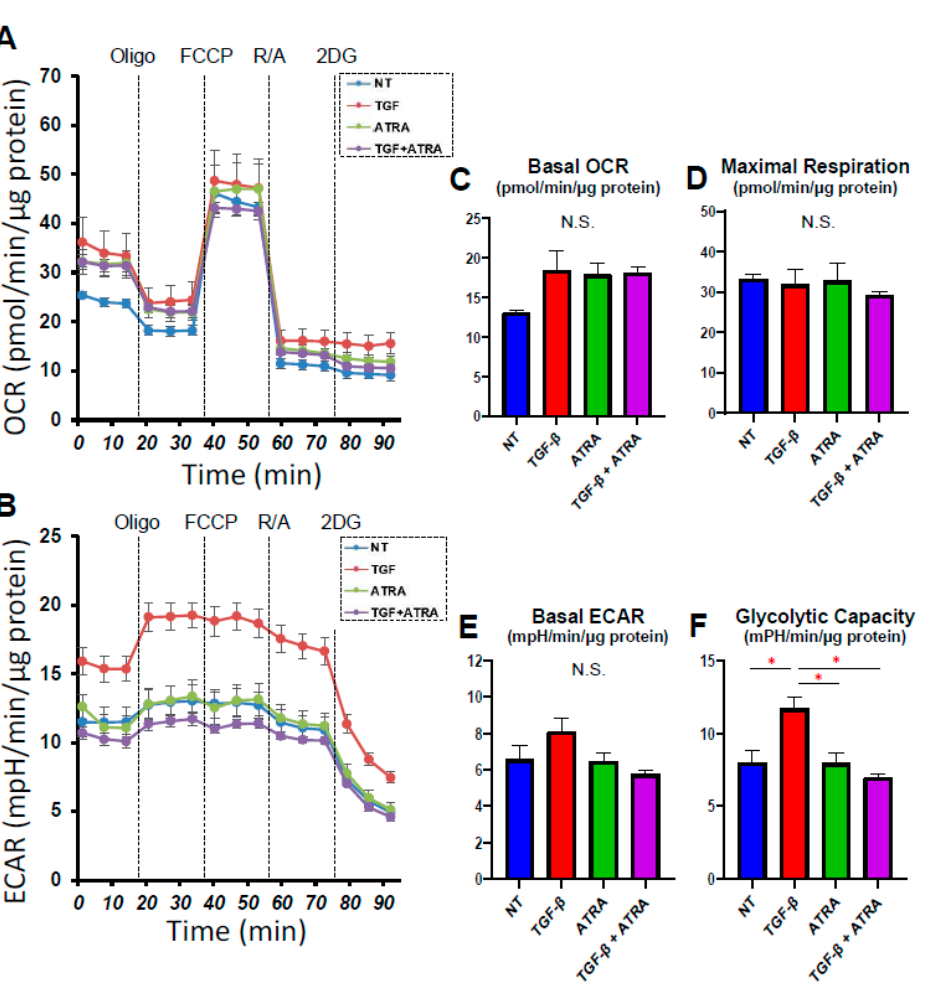
of the 3D spheroids rather than the total expressions detected by qPCR analysis. Similar to these effects observed in ECM molecules, the gene expression of their modulators, TIMPs, MMPs, and ER-stress-related factors, were not significantly affected by TGF- β 2, except Figure 1. Effects of barrier functions of TGF- β 2 untreated or treated HconF 2D monolayers. HconF for the upregulation of MMP2 (2D). In the case of 2D and 3D cultures, ATRA significantly cell 2D monolayers treated with TGF- β 2 (TGF β , 5 ng/mL) and untreated monolayers were subjected modulated the expressions of these molecules but in different manners (Figures 6 and 7). to analyses of TEER and FITC dextran permeability as their barrier functions in the absence or pres- That is, in the case of 2D HconF cells, MMP 14 was upregulated, but in the case of 3D ence of 1 μ M ATRA. Plots of the electric resistance ( Ω cm 2 ) by TEER and the absorbance of the per- HconF spheroids, TIMP1 and 2, MMP14, and CHOP were upregulated, and TIMP3 and meated fluorescein are shown in panels ( A , B ), respectively. Experiments were repeated in triplicate 4, MMP2 and 9, and sXBP were downregulated. Thus, these collective results suggest ( n = 5 each). All data are expressed as the mean ± the standard error of the mean (SEM). *** p < 0.005 that ATRA exerts unfavorable effects on human conjunctival scarring itself by stimulating and **** p < 0.001; ANOVA followed by a Tukey’s multiple comparison test. TGF- β 2-induced effects, especially in the case of spreading in the vertical direction.